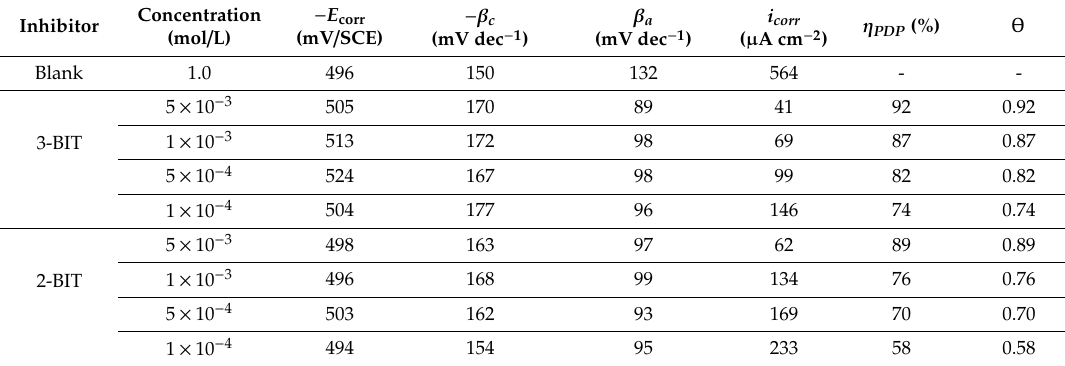
Table 3. Electrochemical impedance spectroscopy (EIS) results recorded for MS in the acidic Table 4. Potentiodynamic polarization (PDP) results obtained for MS in 1.0 M HCl at di ff erent concentrations of 3-BIT and 2-BIT along with their corresponding inhibition e ffi ciency.